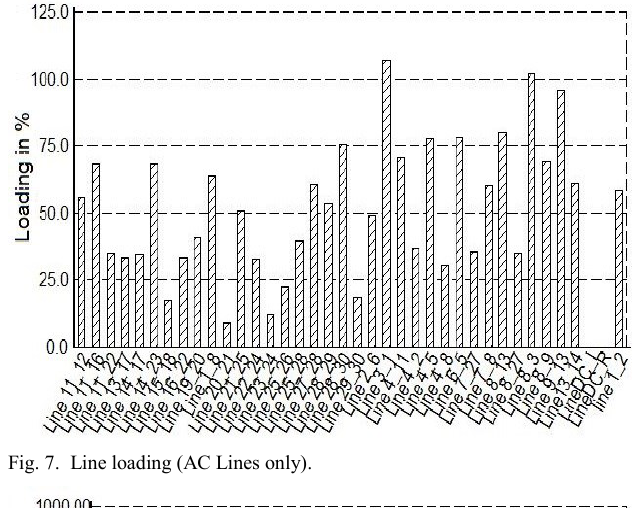
Fig. 6. Busbar voltage magnitudes.